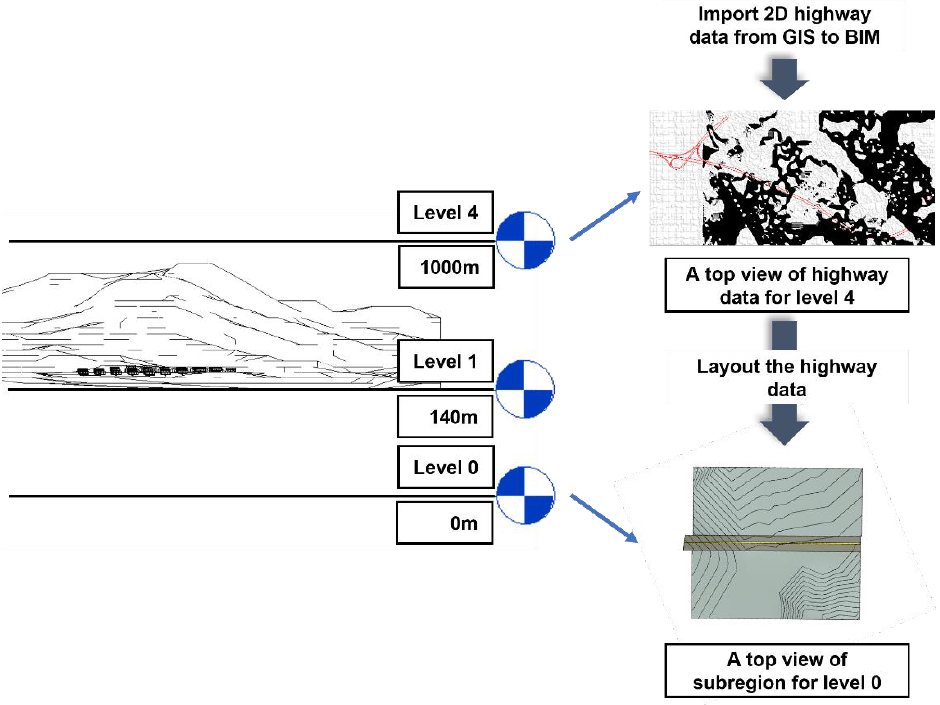
Figure 6. Plan view of the PV plant installation from the north (left) and the top (right).